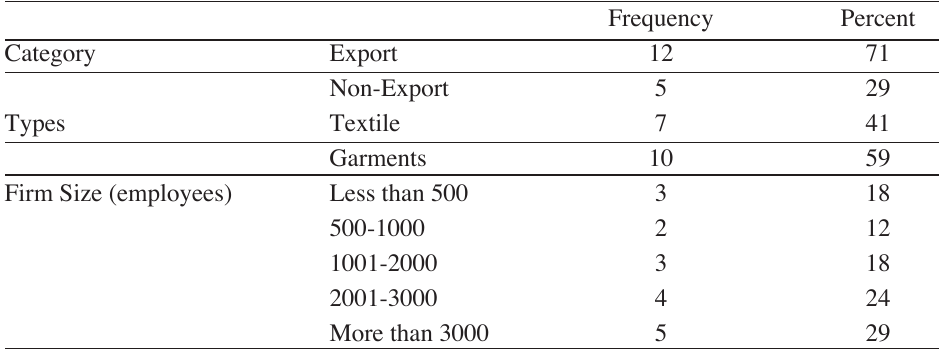
Profile of Respondent